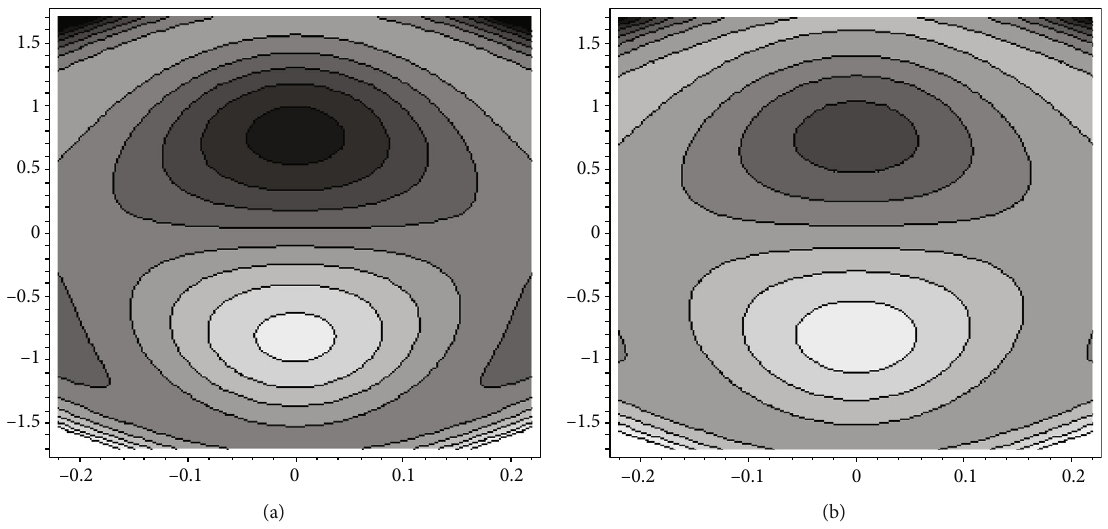
Figure 20: Stream lines for di ff erent values of β . The other parameters are φ = 0 : 7 , We = 0 : 51 , y = 1 , n = − 0 : 8 , and Q = 2 : 0 .